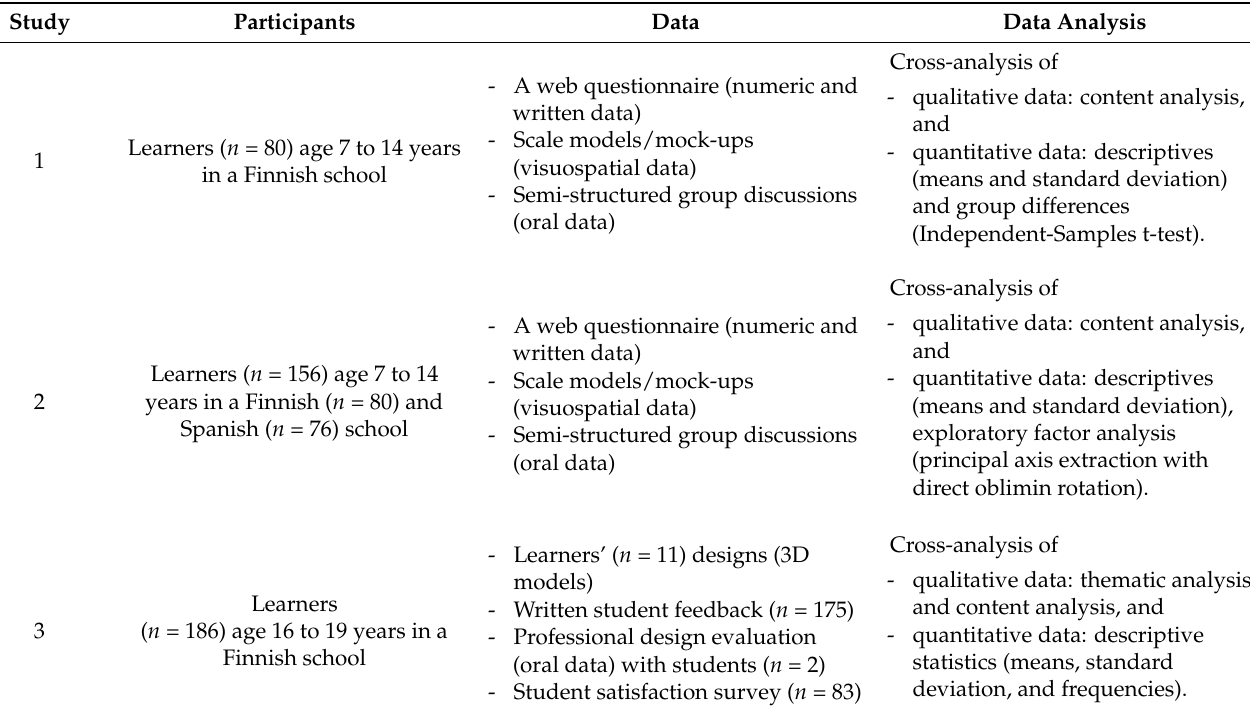
Table 1. Participants, data, and data analysis of each